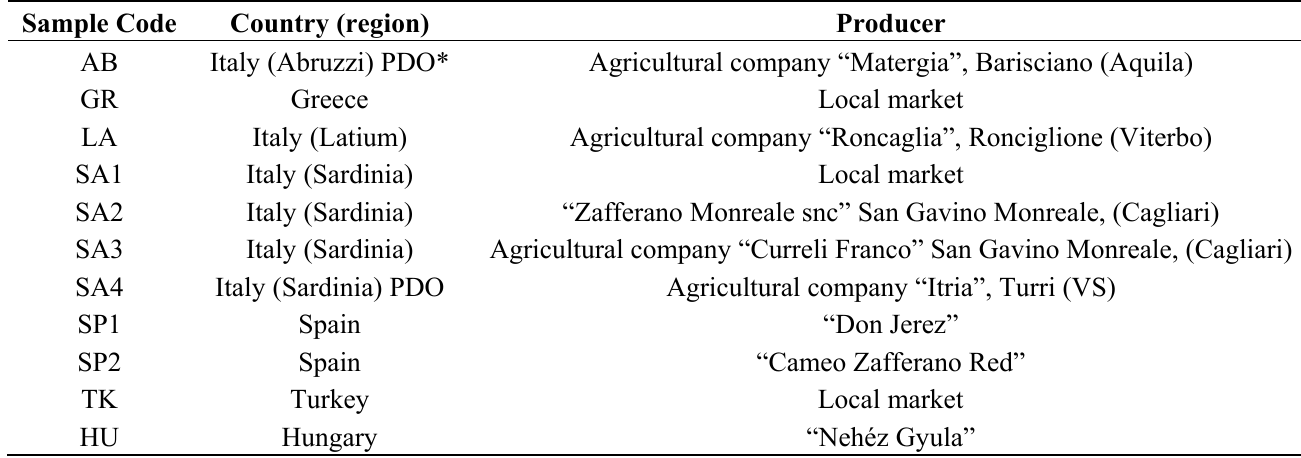
Table 1. Saffron samples used in the